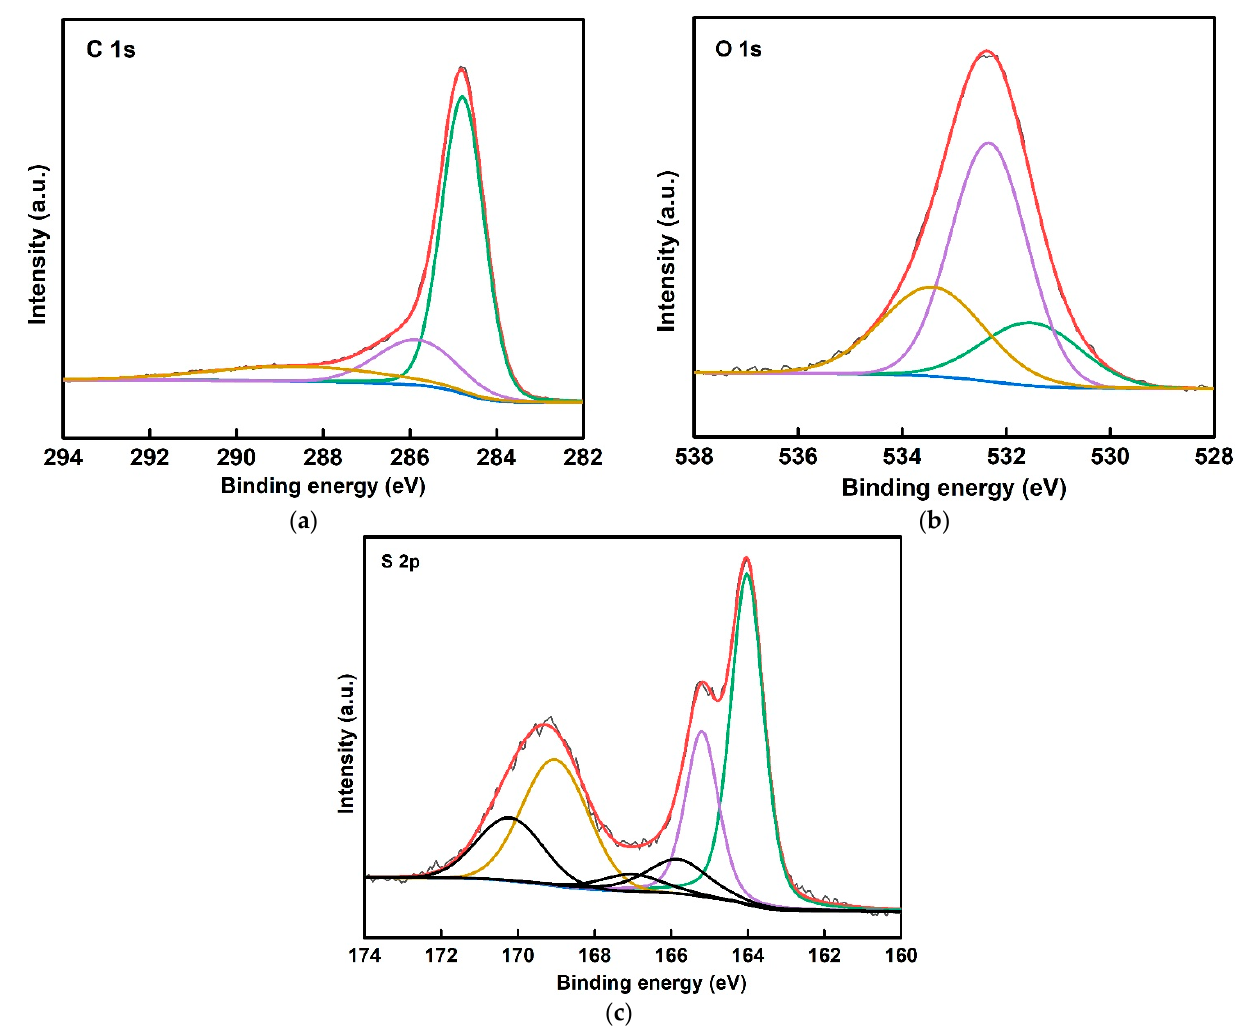
Figure 5. XPS spectra of S-C for ( a ) C 1s, ( b ) O 1s, and ( c ) S 2p.